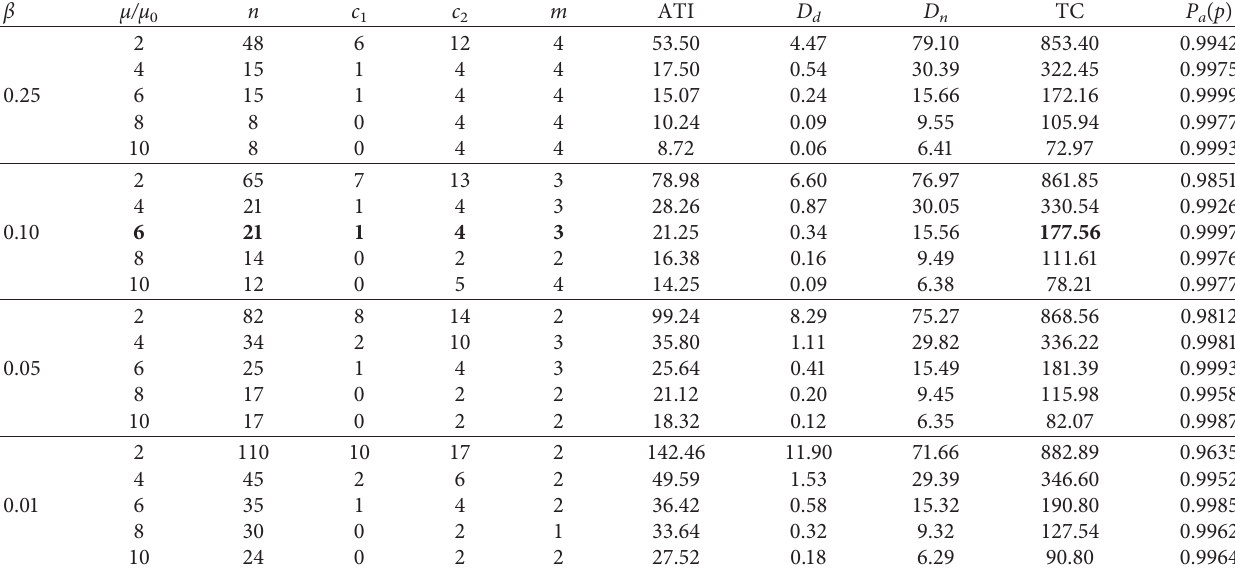
Table 8: Optimal parameters of economic modified MDS sampling plan for assuring Weibull distributed mean life with a � 0.5 and δ � 2. β μ/μ